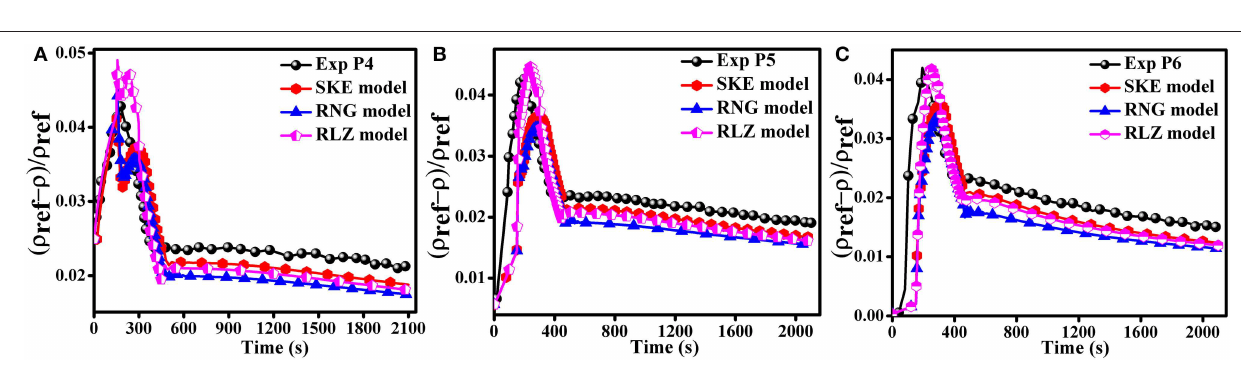
also underestimated for the RLZ turbulence model. The